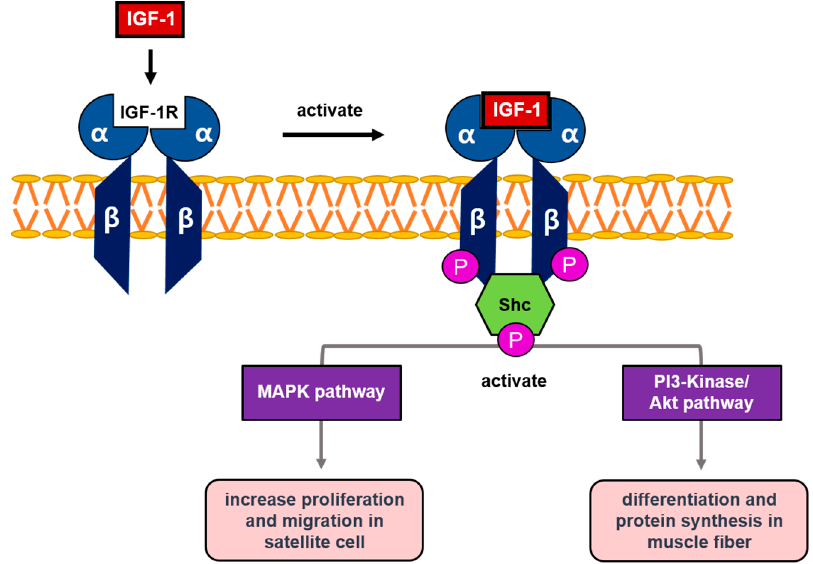
Figure 2. The molecular mechanism of IGF-1. IGF-1 interacts with its receptor (IGF-1R), and thus, activates the PI3K/Akt and mitogen-activated protein kinase (MAPK) pathways, which regulate MSC proliferation and differentiation.